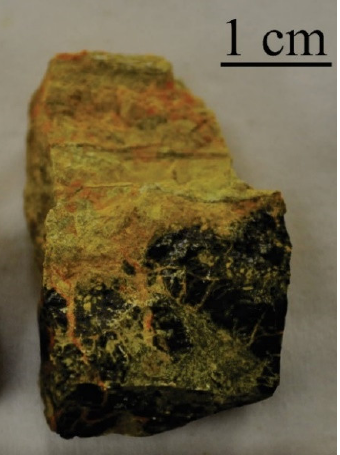
Figure 1. Image of the Northern Territory, Australia uraninite sample (Australia, #516). This sample